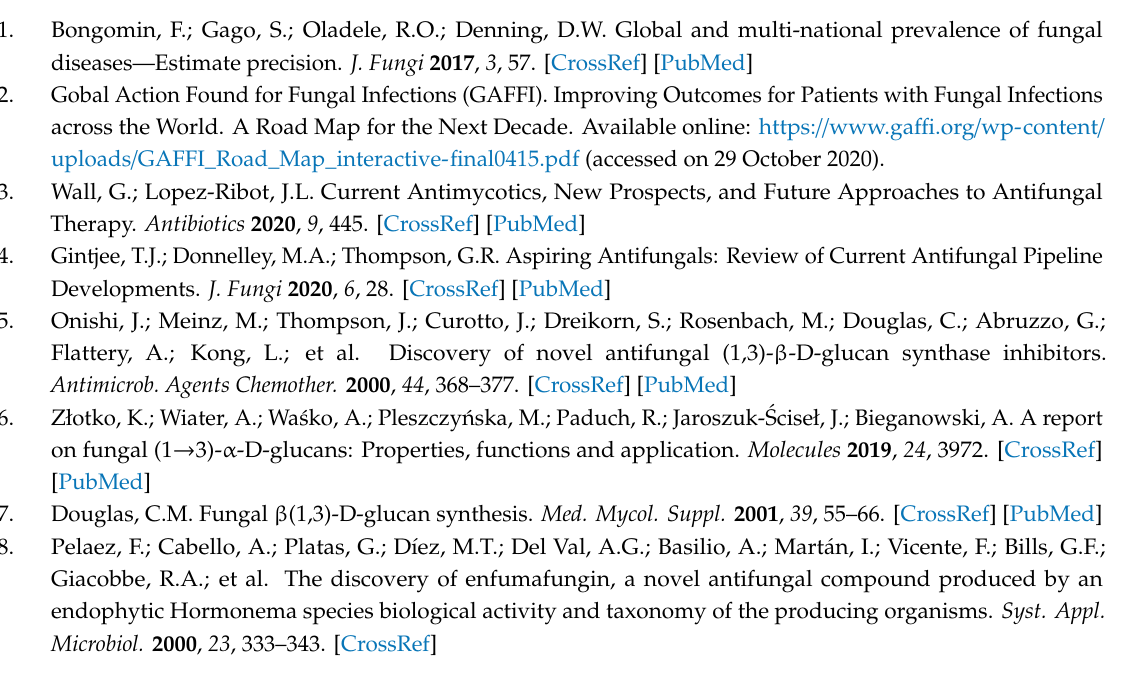
Table S1: In vitro data for rezafungin and the other echinocandins used ass comparators for Candida spp. and Aspergillus spp. determined by CLSI and EUCAST susceptibility testing method. Funding: This research received no external funding. Conflicts of Interest: The author declares no conflict of